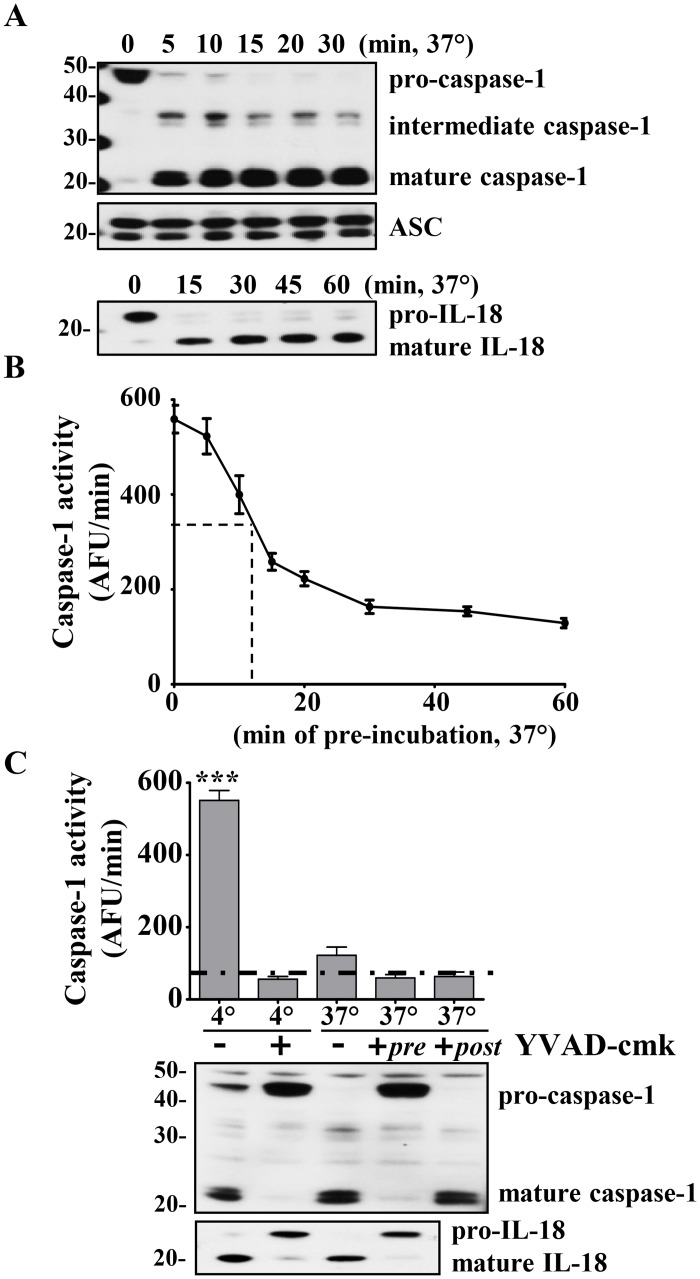
Caspase-1 activity in cell-extract decreases over time.A) Rapid cleavage of caspase-1 and IL-18 into their mature forms during incubation of cell extract from 3x108 THP1 cells/ml at 37°C. ASC was used as a loading control. B) Cell-extracts were pre-incubated at 37°C for various time points and then loaded simultaneously into the fluorimeter and caspase-1 activity (measured as maximal slope: AFU/min) was measured. Dashed line denotes half-life. C) YVAD-cmk (50 μM) inhibits caspase-1 activity and cleavage. Cell-extracts were incubated at 4 and 37°C in presence or absence of YVAD-cmk for 1h and WEHD-afc cleavage measured (AFU/min). Non-YVAD-cmk inhibitable baseline activity is indicated below the dashed-line. Immunoblots for caspase-1 activation and cleavage of endogenous IL-18 was used to confirm caspase-1 specific activity. ***: p<0.0001(ANOVA). Representative gels from n = 4 and n = 3 independent experiments (A and C, respectively). Data are expressed as mean ± SEM for n = 4 (B) and n = 3 (C) independent experiments.